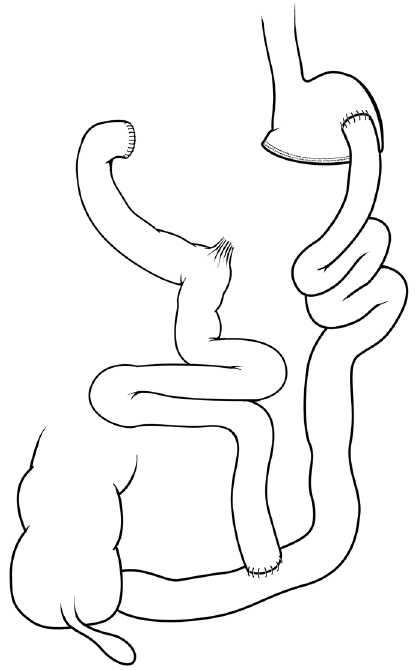
Figure 4. Biliopancreatic diversion. This operation essentially diverts bile and pancreatic secretions to the distal bowel for mixing with nutrients/chyme, typically much further distal than a Roux-en- Y gastric bypass. Traditional biliopancreatic diversion consists of a modest reduction in stomach volume, typically about 300–400 mL, as well as the diversion of bile and pancreatic secretions. Reprinted with permission 35 .